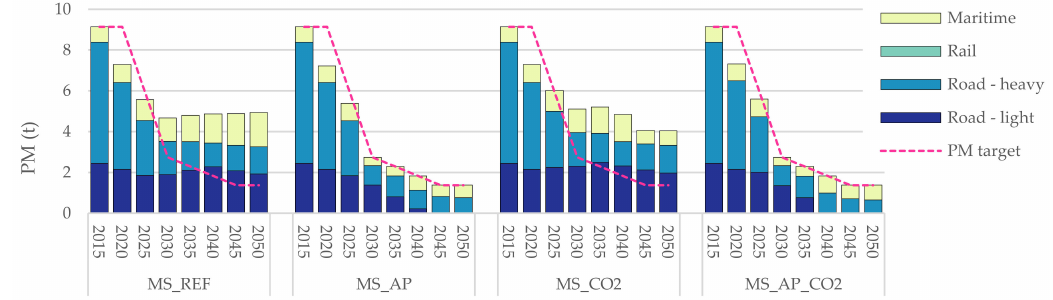
Figure A8. By-mode tailpipe emissions of particulate matter (PM) in the mode shift (MS) scenarios (t). Note : Road—heavy = buses, MGVs and HGVs; Road—light = cars and LCVs.